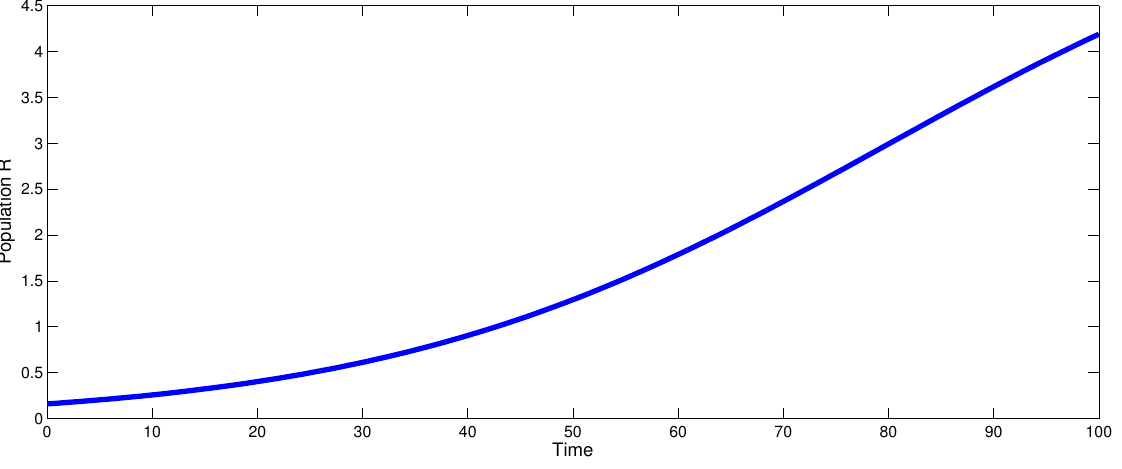
Fig. 11. Diagram of the recovered population ( R ) without of control based on Table 1, 2 and G 1 = 0 . 005 , G 2 =